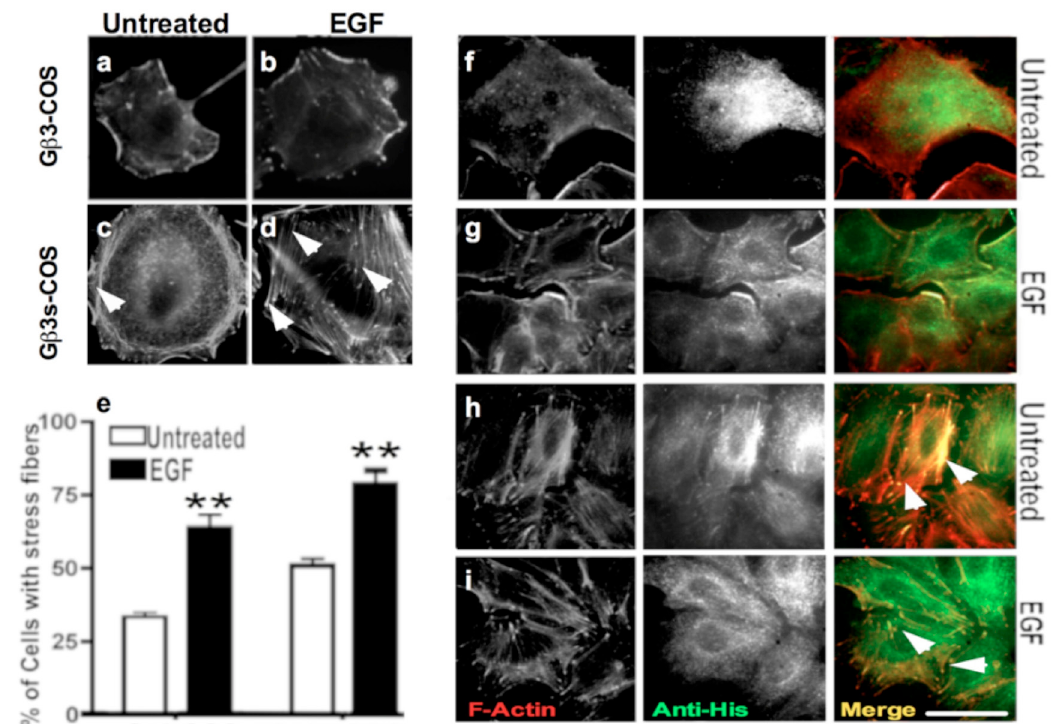
Figure 6. Gβ3s subunit co-localises with F-actin and enhances actin stress fiber formation. G b 3-COS and G b 3s- COS cells were either left untreated or treated with EGF followed by F-actin staining using Alexa fluor 568 conjugated phalloidin. G b 3s-COS cells exhibit enhanced stress fiber formation (white arrow heads) both in untreated (c) and EGF stimulated (d) when compared to G b 3-COS untreated (a) and EGF stimulated (b). The number of cells exhibiting stress fiber formation were counted as mentioned in material and methods and plotted as graph to represent % of stress fiber forming G b 3s-COS and G b 3-COS cells (e). Increased Anti-His staining and co-localisation within F-actin stress fibers (arrow heads) is observed in HA-G b 3s-COS cells both in basal (h) and EGF treated states (i) when compared to anti His staining of HA-G b 3-COS (f, g). Images were taken from different fields of view under a 40x objective with further 1.5x magnification. Bar = 13 m